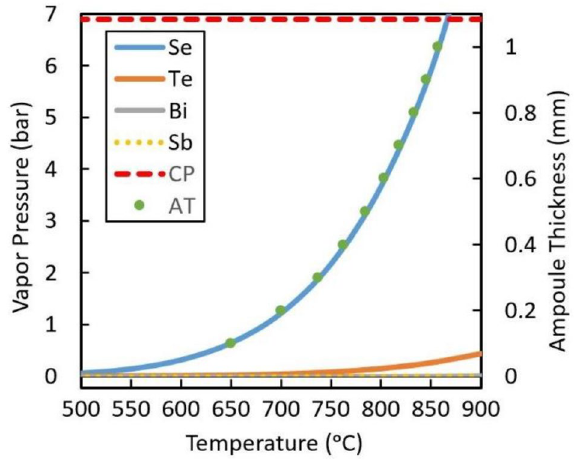
Figure 1. The Clausius–Clapeyron equation has been used to describe the relationship between temperature and vapor pressure for the BSTS system elements starting from 500 to 900 °C with ampoule thickness as a third axis. (CP) is the critical point at which the ampoule equation limits at, and (AT) is the ampoule thickness of the quartz